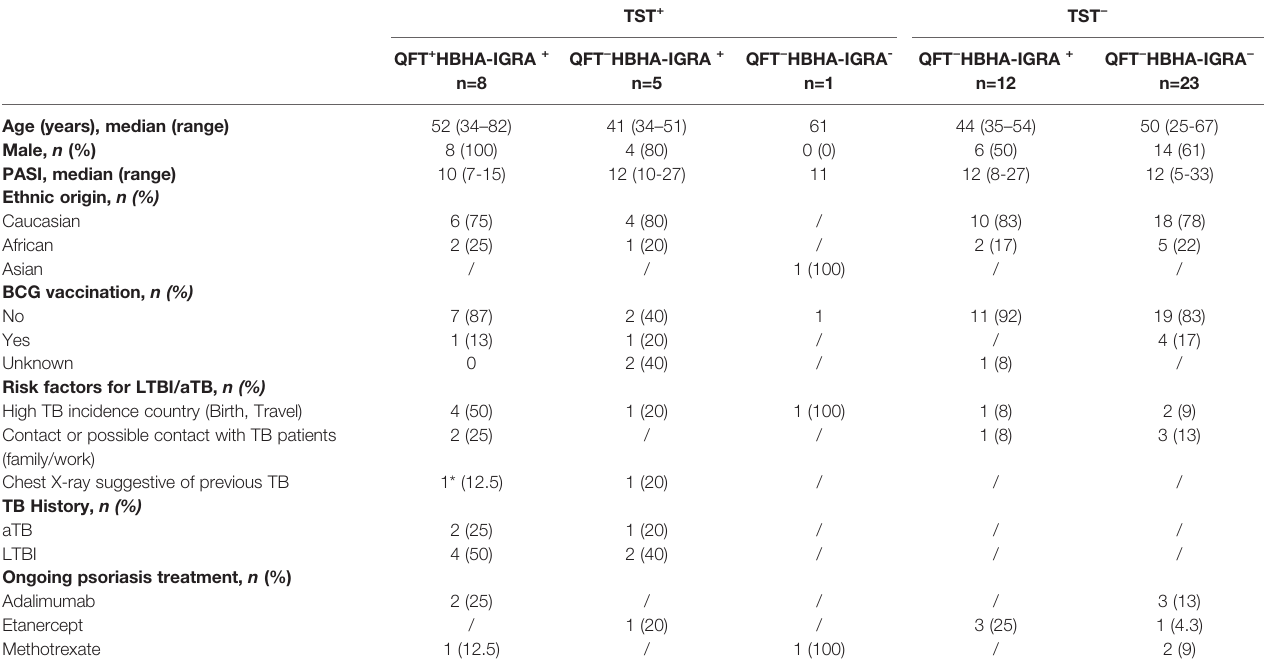
TABLE 1 | Demographic and clinical characteristics of the study population.